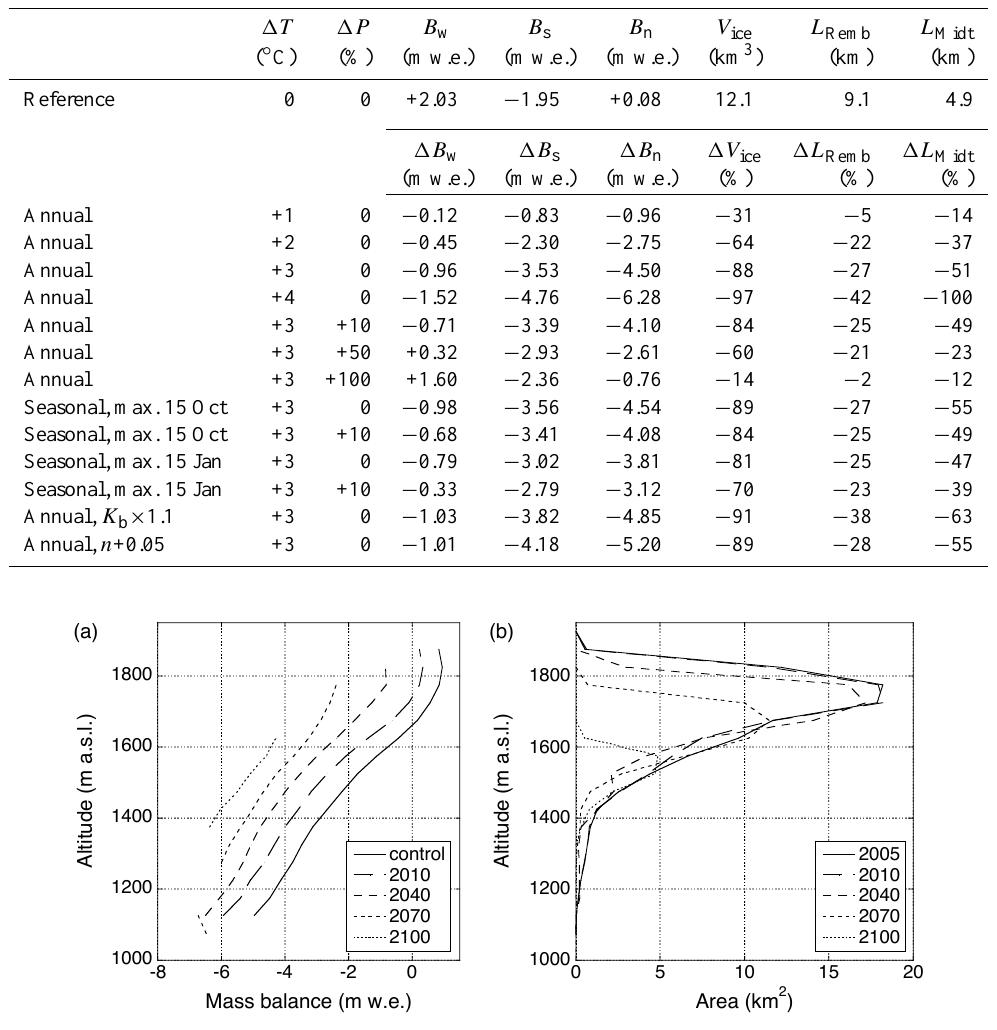
Fig. 12. Modelled (a) net mass balance profile and (b) area distribution for 2010, 2040, 2070 and 2100, for the climate projection with 1T =+3 ◦ C and 1P =+10%. The mass balance profile for the control climate and the area distribution at the end of 2005 are shown for